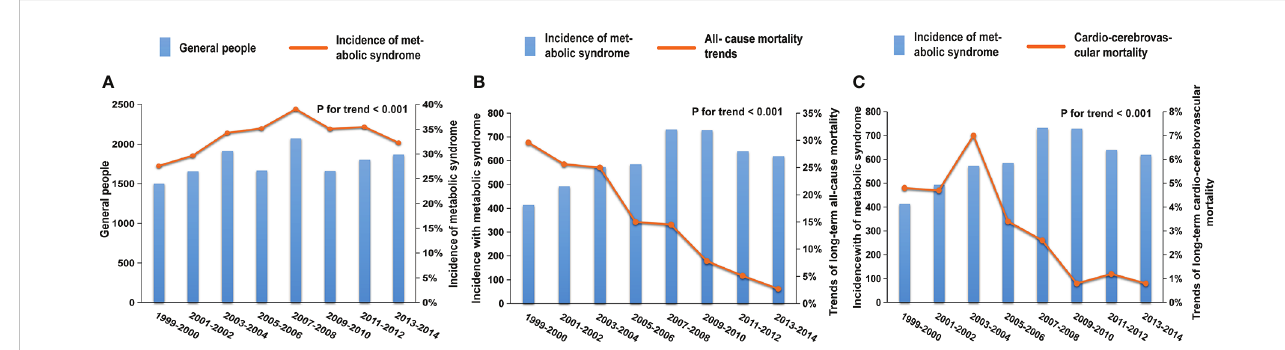
FIGURE 2 Trends in the incidence and mortality of MetS patients in the NHANES from 1999 to 2014; (A) The prevalence of MetS increased signi fi cantly from 27.6 to 32.3% (adjusted odds ratios [aOR], 1.71; 95%CI, 1.42-2.05; P-value <0.001, P for trend <0.001); trends in all-cause (B) and cardio-cerebrovascular (C) mortality of MetS patients in the NHANES from 1999 to 2014. After an average of 7.7 years offollow-up, the all-cause mortality (from 29.6 to 2.7%; [aOR], 0.12; 95%CI, 0.07-0.21; P-value <0.001, P for trend <0.001) and cardio-cerebrovascular mortality (from 4.8 to 0.8%; [aOR], 0.17; 95%CI, 0.05- 0.61; P-value =0.007, P for trend <0.001) of MetS patients showed obvious downward